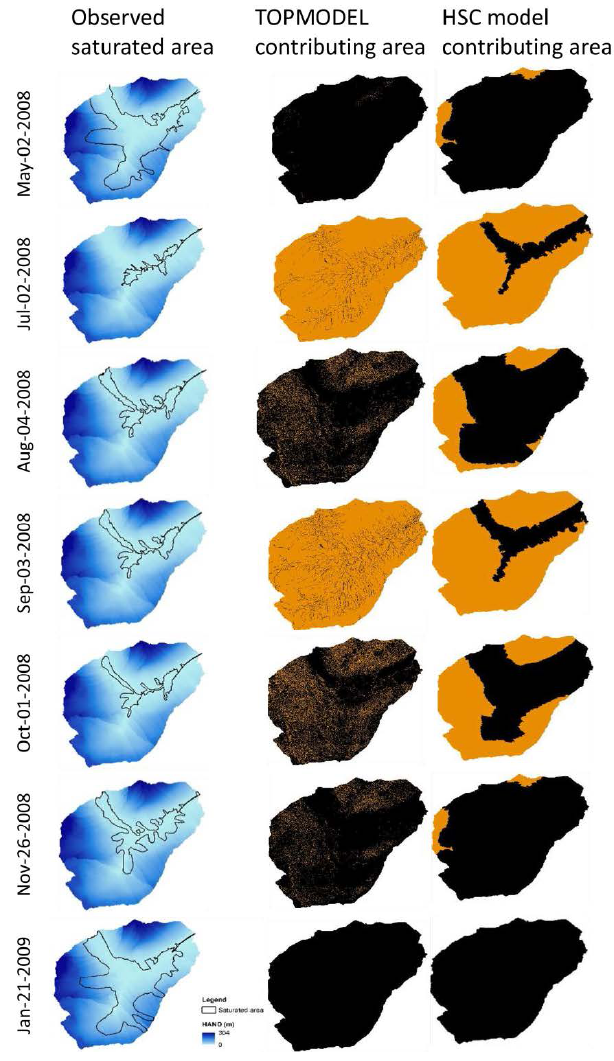
Figure 7. The measured saturated areas and the simulated contribut- ing areas (black) by TOPMODEL and HSC